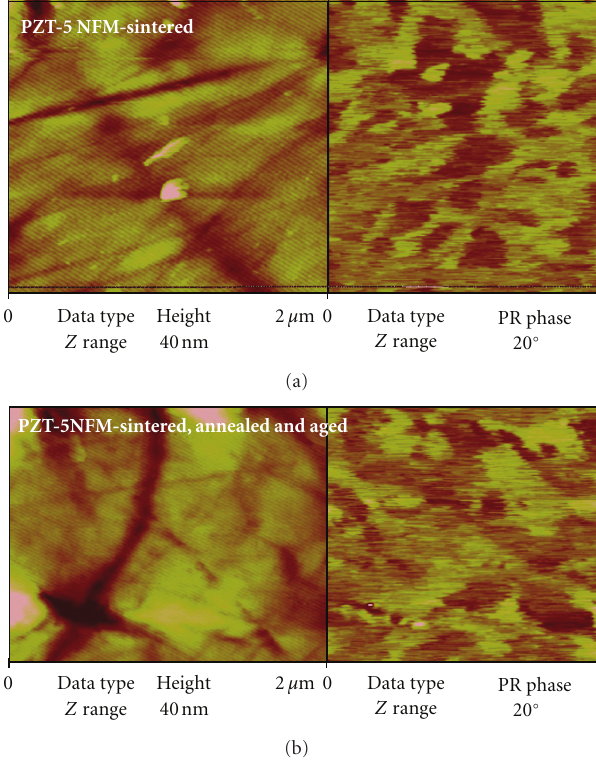
Figure 13: PFM images of PZT-5 NFM after (a) sintering, (b)